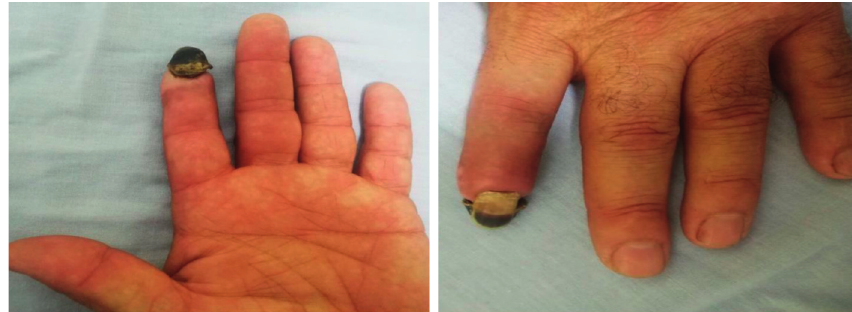
Figure 3: Photo of the patient’s left hand showing the gangrenous distal phalanx of his left index